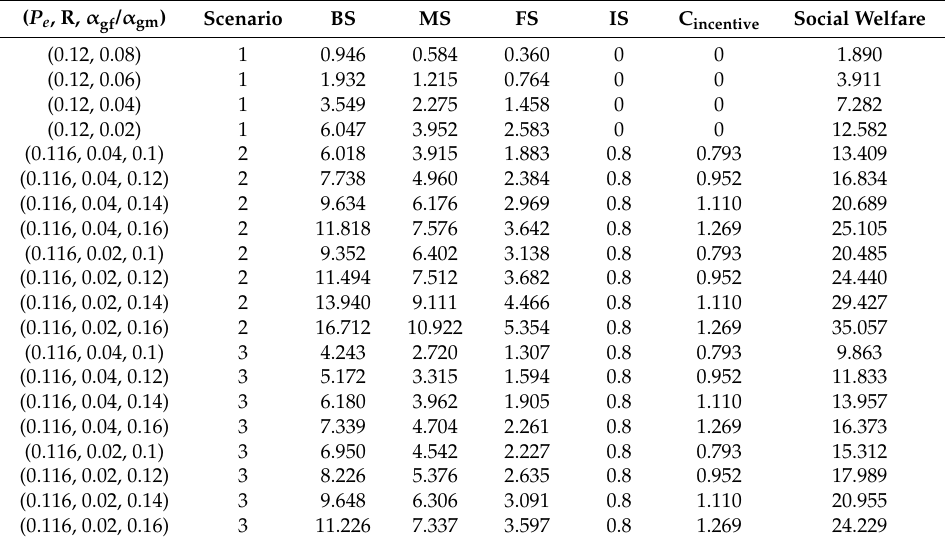
Table 2. Results of social welfare in all scenarios (US$